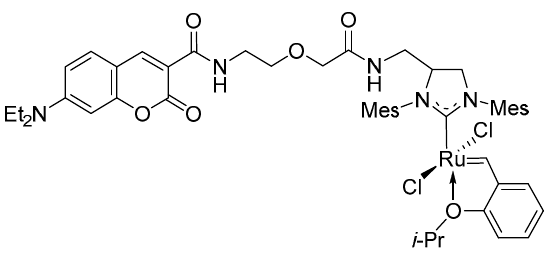
Figure 8. Glycosylated Hoveyda–Grubbs-type artificial metalloenzyme (Alb-Ru).